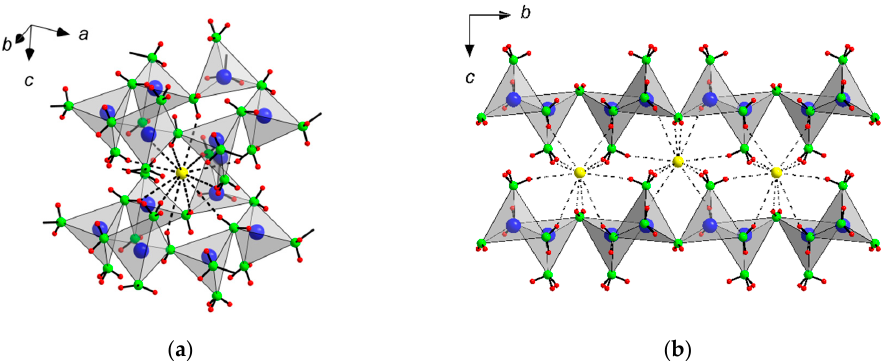
(cid:104) (cid:105) Zn ( NH 3 )( NH 2 ) 3/21/2 + within the third